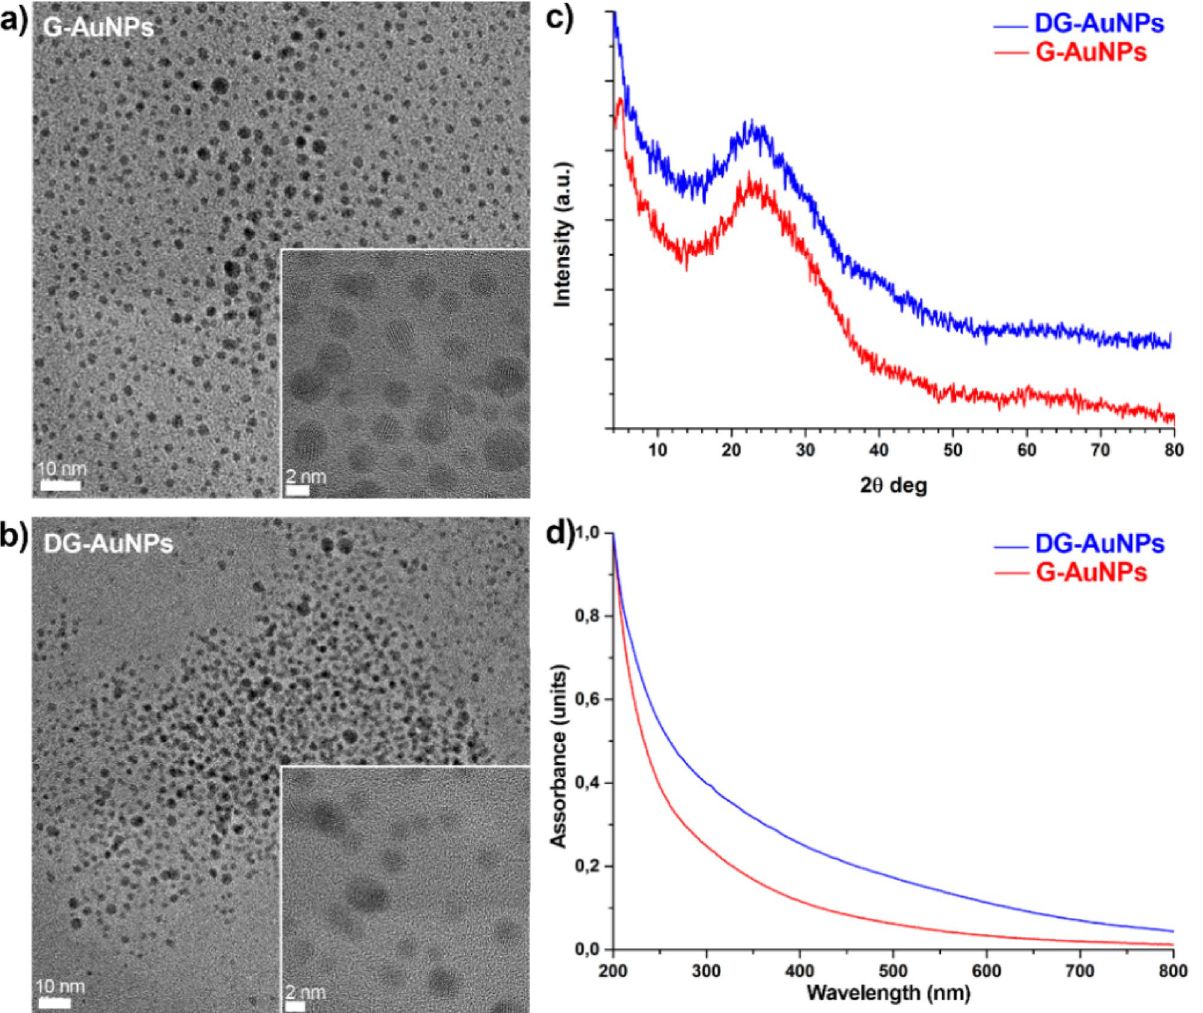
Figure 1. TEM micrographs of G-AuNPs ( a ) and DG-AuNPs ( b ). Powder WAXD diffractograms ( c ) and UV– Vis-NIR spectra ( d ) of G-AuNPs and